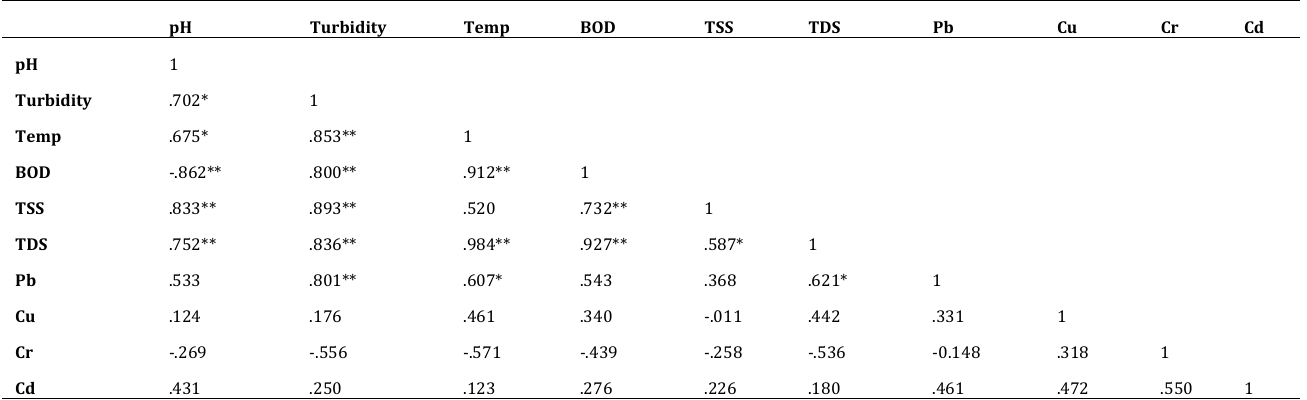
Table 6: Person correlation for spring-water at Tamalang village, Kota Belud.